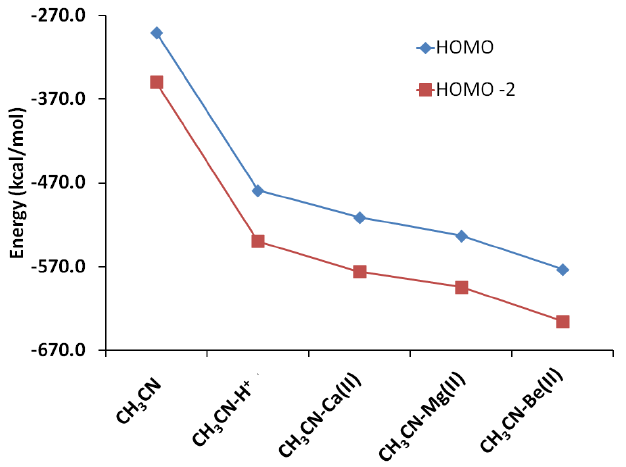
Figure 11. Lowering of acetonitrile MO energies due to interaction with cations [calculated using B3LYP/6-31 + G(d,p)].